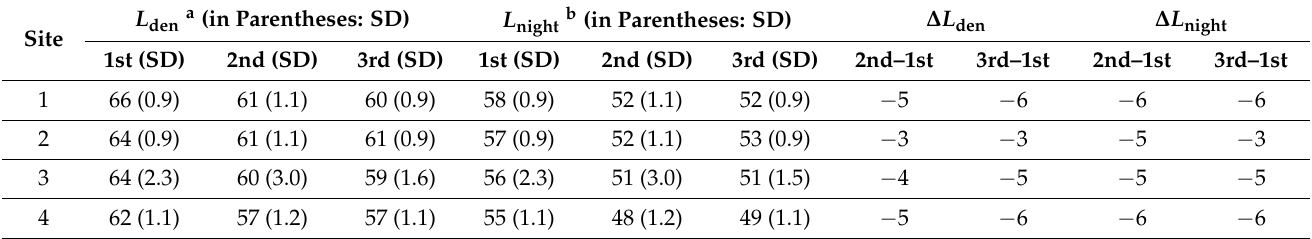
Table 4. Average noise levels (dB) and standard deviation (SD) estimated for each survey site during the survey